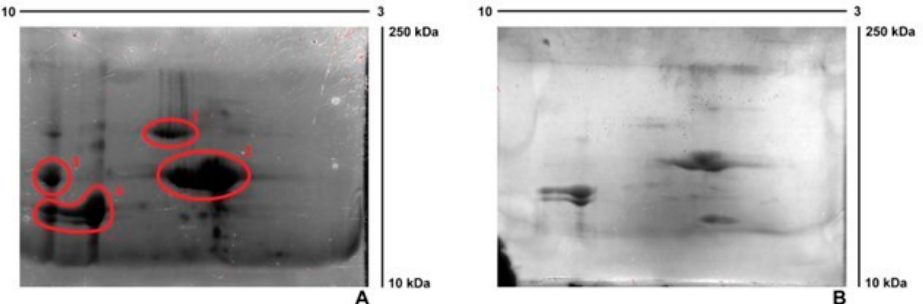
Figure 2. 2D-PAGE of APs: samples were separated using IPG strips (3–10). ( A ) in the absence of mTGase. ( B ) in the presence of mTGase (40 U/g).